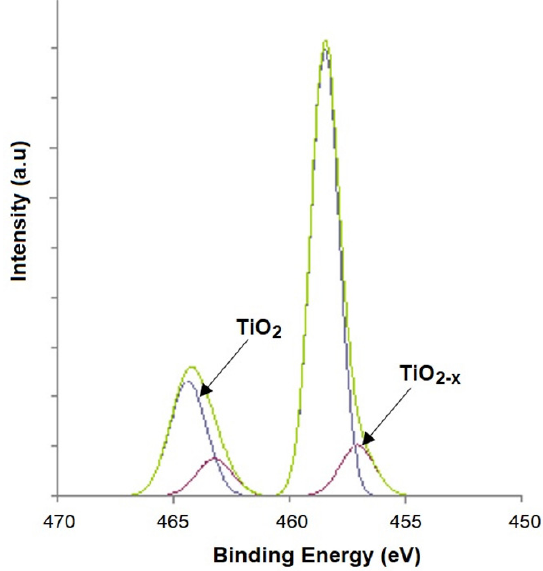
Figure 4. Individual XPS spectra of titanium in a coating on a zinc substrate.